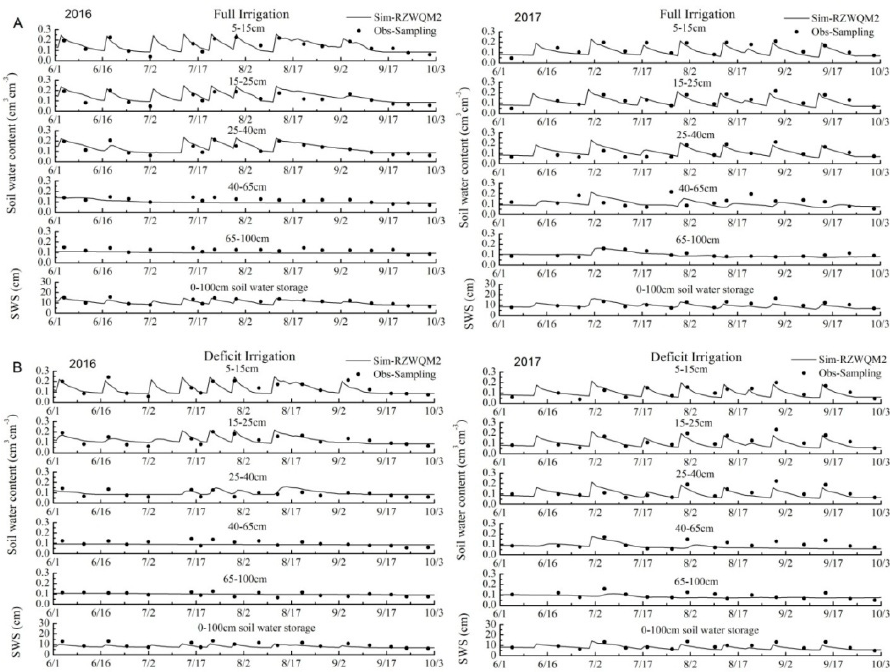
Figure 11. Simulated and measured soil water content for the full irrigation field ( A ) and deficit irrigation field ( B ) based on DSSIS in 2016 and 2017.